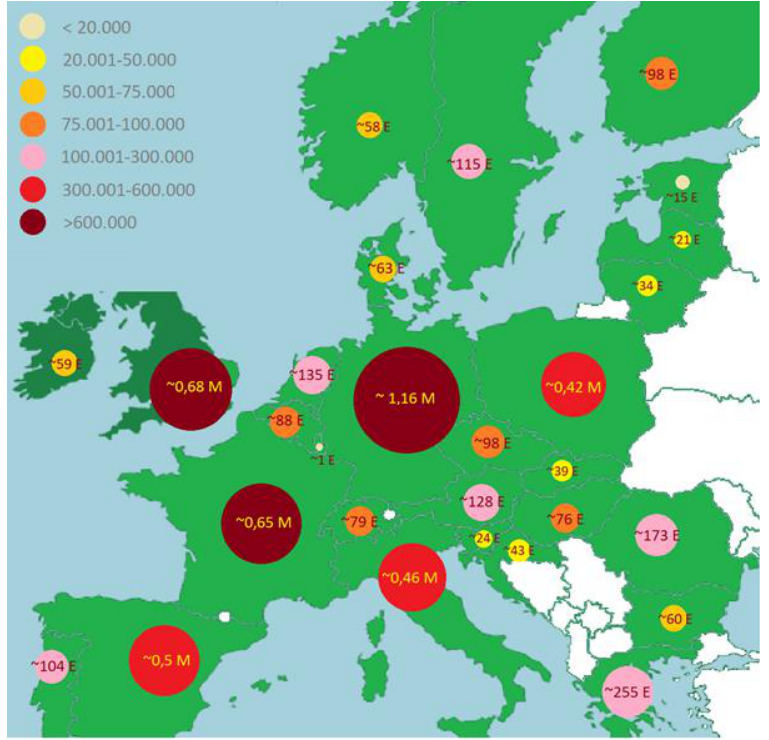
Fig. 3. Based on Eurostat. STEM Higher Education Numbers. All Levels of Education, All Work Schedules,